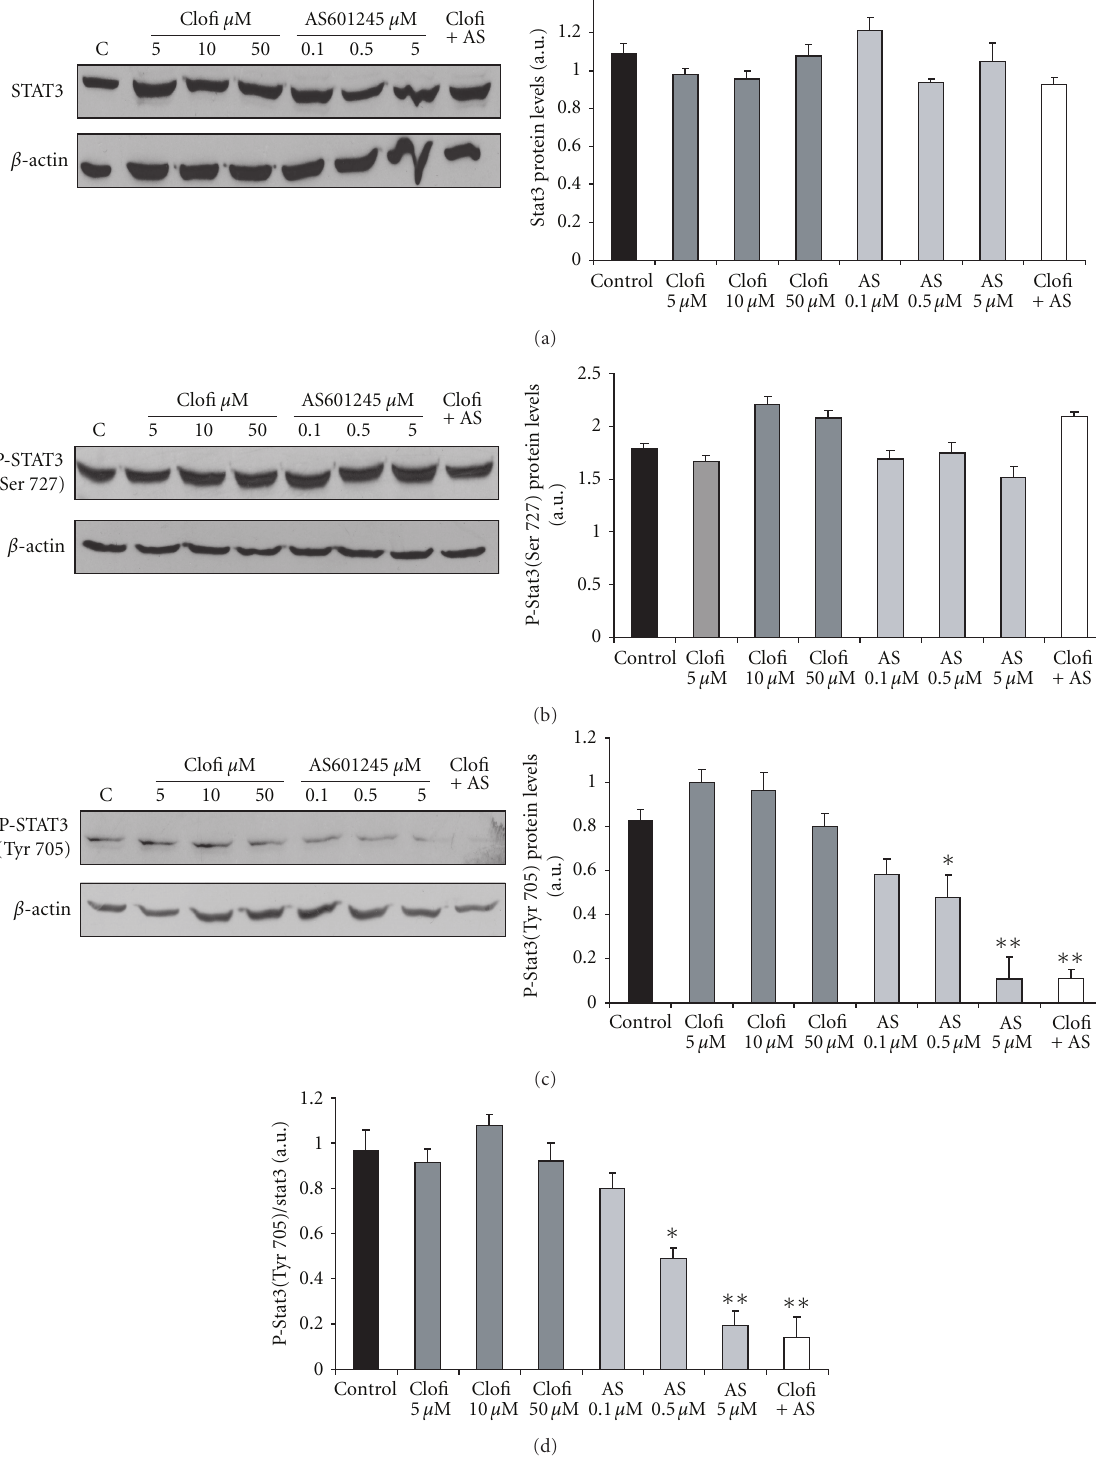
Figure 7: Analysis of JAK/STAT signalling. Western Blot analysis of STAT3 (a), P-STAT3 (Ser727) (b), and P-STAT3 (Tyr705) (c) proteins levels analyzed in CaCo-2 cells treated with clofibrate (Clofi) alone, AS601245 alone at the indicated concentrations, and combined treatment with 5 μ M clofibrate and 0,1 μ M AS601245 (Clofi + AS) and collected at 24 hours after the treatment. Graphics represent the relative quantification of protein products performed by densitometric scanning. Data were normalized by using the β -actin signal and expressed as arbitrary densitometric units. (d) Graphics represent the normalization of the protein level of P-STAT3 (Tyr705) by using STAT3 signal. Results are the mean ± SD of three separate experiments from three di ff erent preparations for each condition. Variance analysis: ∗ P < 0 . 05, ∗∗ P < 0 . 01 versus